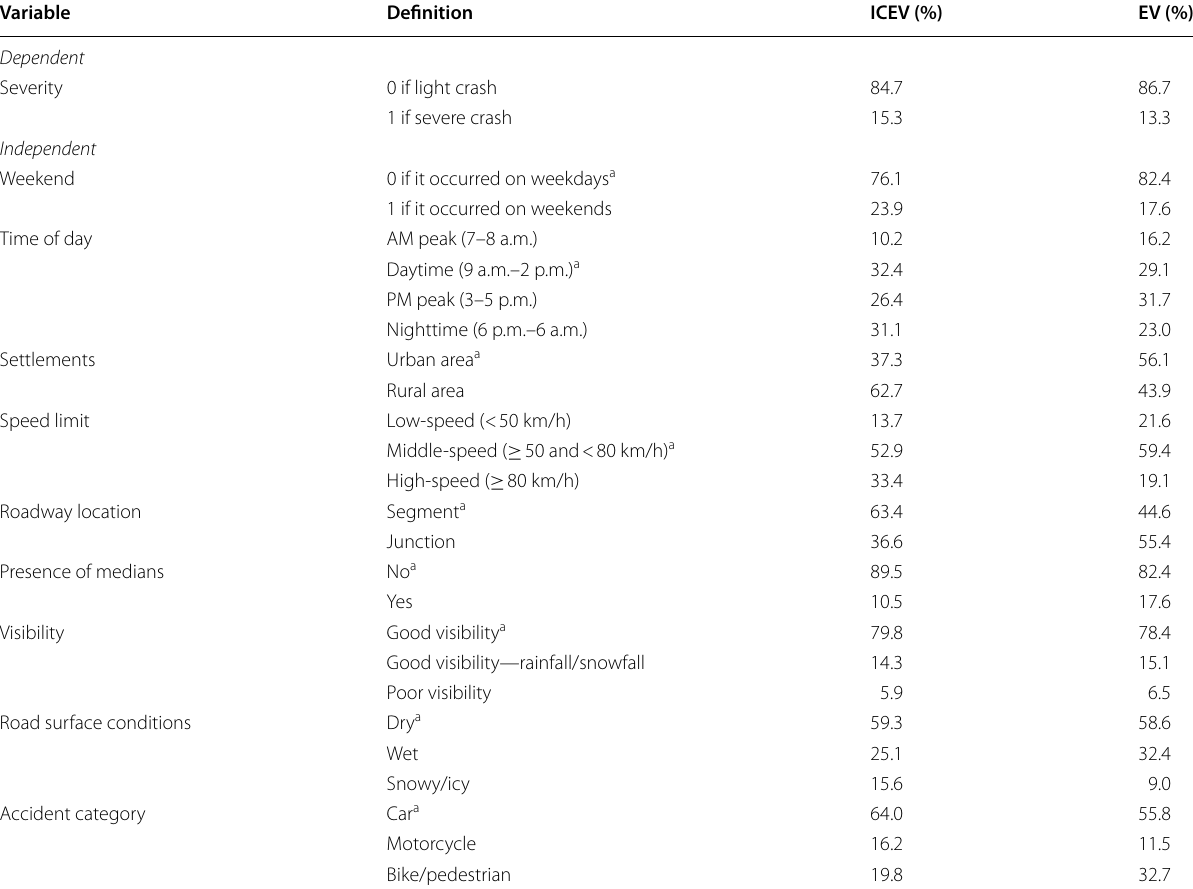
a Indicates the baseline of the